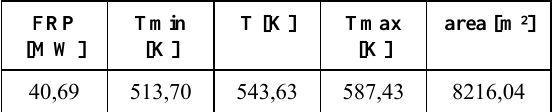
Table 2: TET derived HTE parameters for Villarrica.